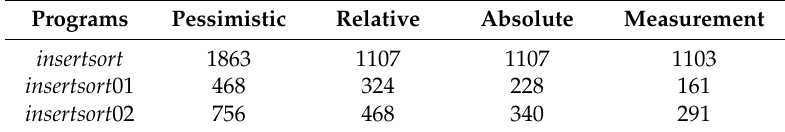
Table 1. WCET estimations obtained by using different constraints (unit: